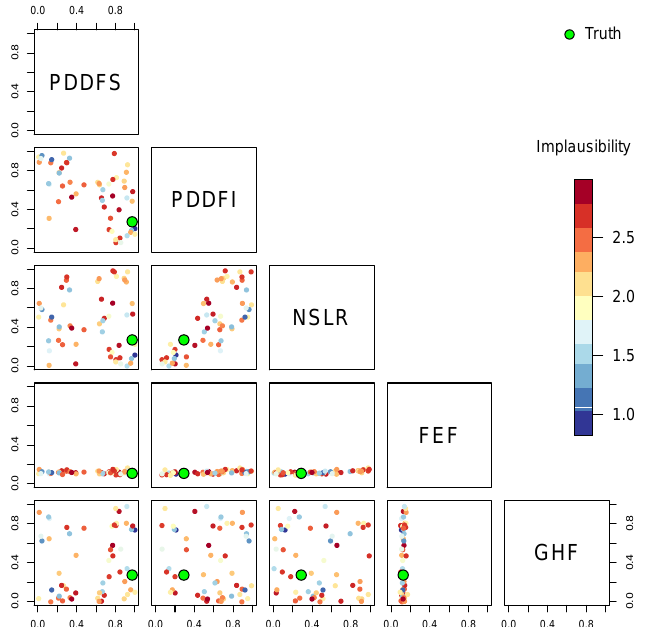
Fig. 4. Two-dimensional projections of emulated “not implausible” ( I < 3 ) ensemble members, when the true inputs are those of the (arbitrarily chosen) first ensemble member. Implausibility is calculated as the maximum of that from all three summaries of the output data – ICEVOL, ICESA and MAXTHK. Emulated implausible members (not shown) are spread evenly through the input space. The true value of the inputs (the target) is shown as a green point.